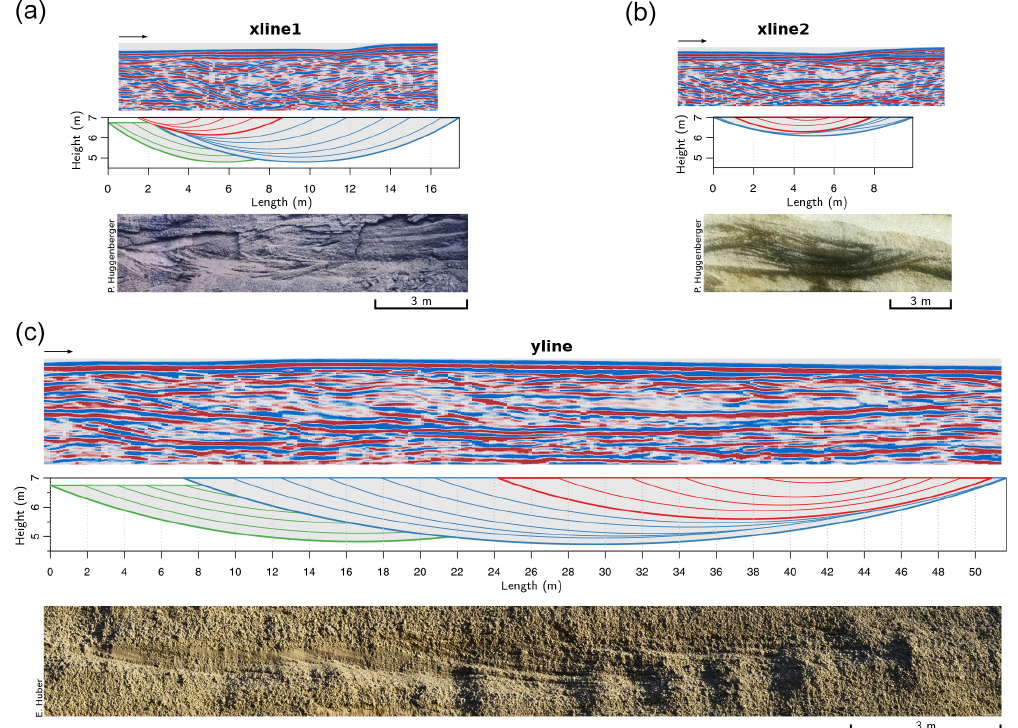
Figure 4. (a) – (c) Ground-penetrating radar data, sections of the geometric model and vertical outcrop exposures (northeast Switzerland) for comparison purposes. The trough fills are represented by green, blue, and red ellipses. The black arrows indicate the GPR survey